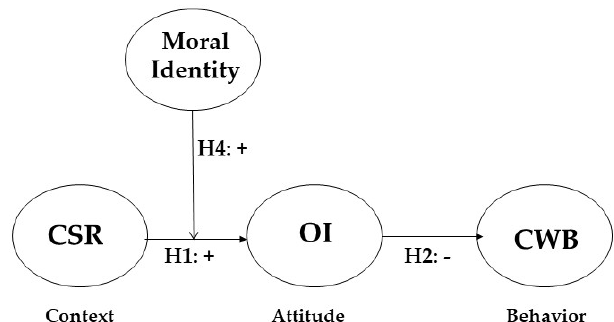
Figure 1. Theoretical Model.